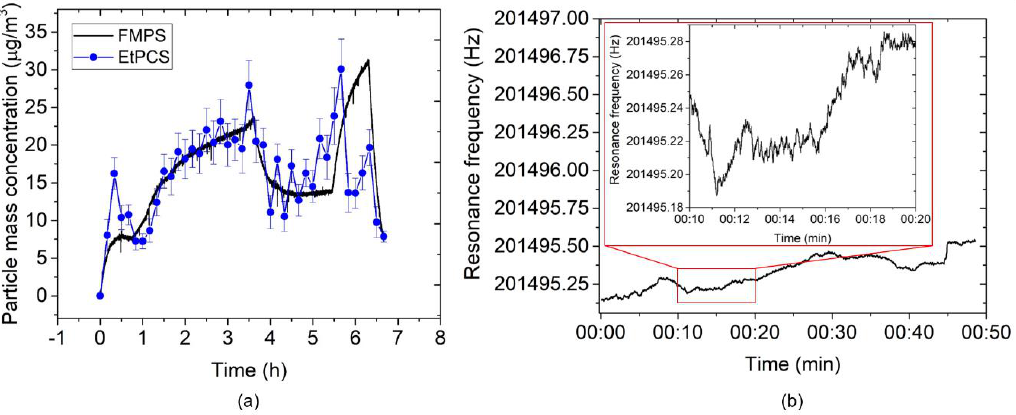
Figure 11. ( a ) Carbon nanoparticle mass concentration measured by the EtPCS (full blue circles) in comparison with FMPS (full black line). ( b ) The frequency stability measurement under a temperature of 22.3 ± 0.4 °C and relative humidity of 23 ± 1%. The inset shows an exemplary detail enlargement of the frequency tracking within 10 min showing σ ≈ 27 mHz.